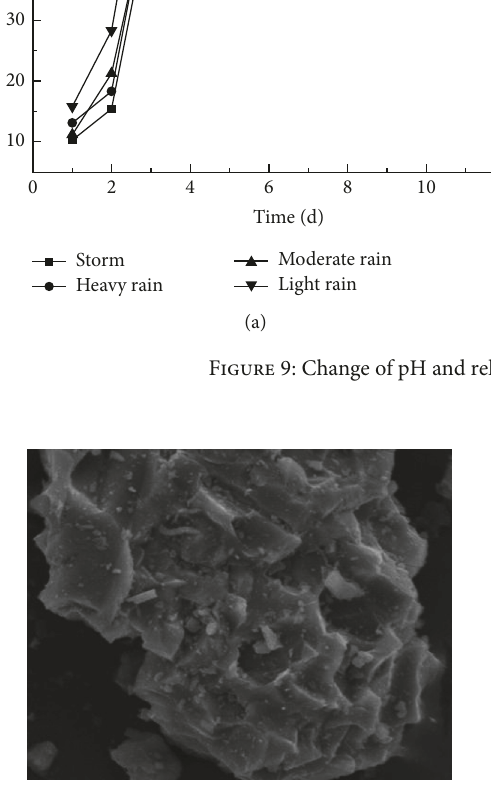
Figure 10: Result of SEM of antimony ore smelting slag.